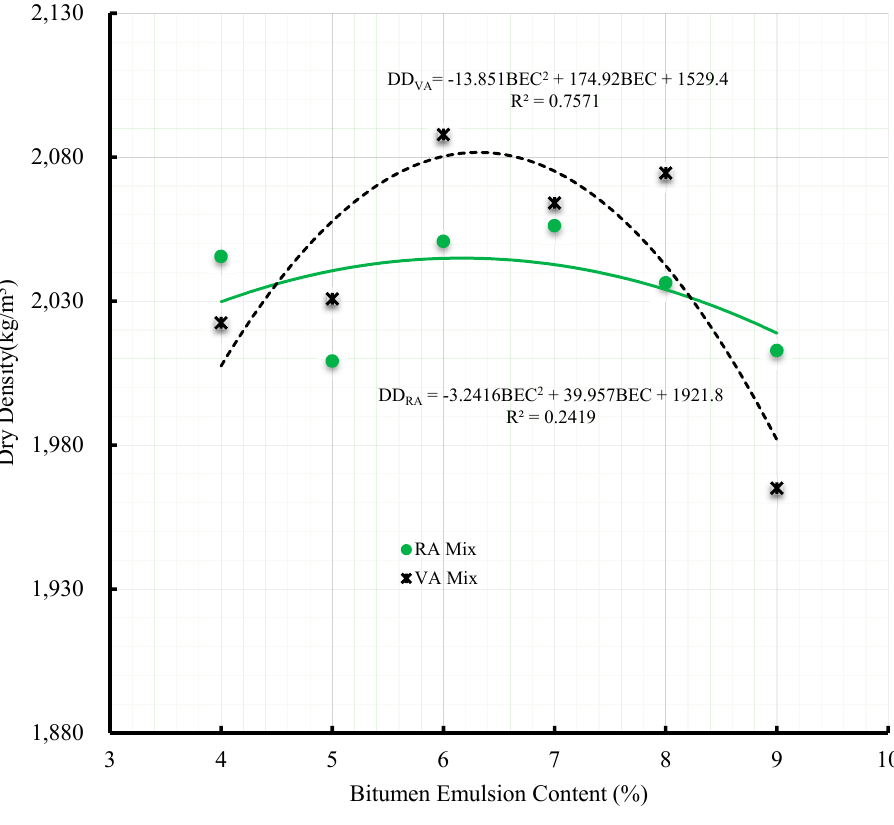
Figure 5. Dry Density for Virgin Aggregates and Reclaimed Asphalt Aggregates Mixes at Optimum Bitumen Emulsion Contents.